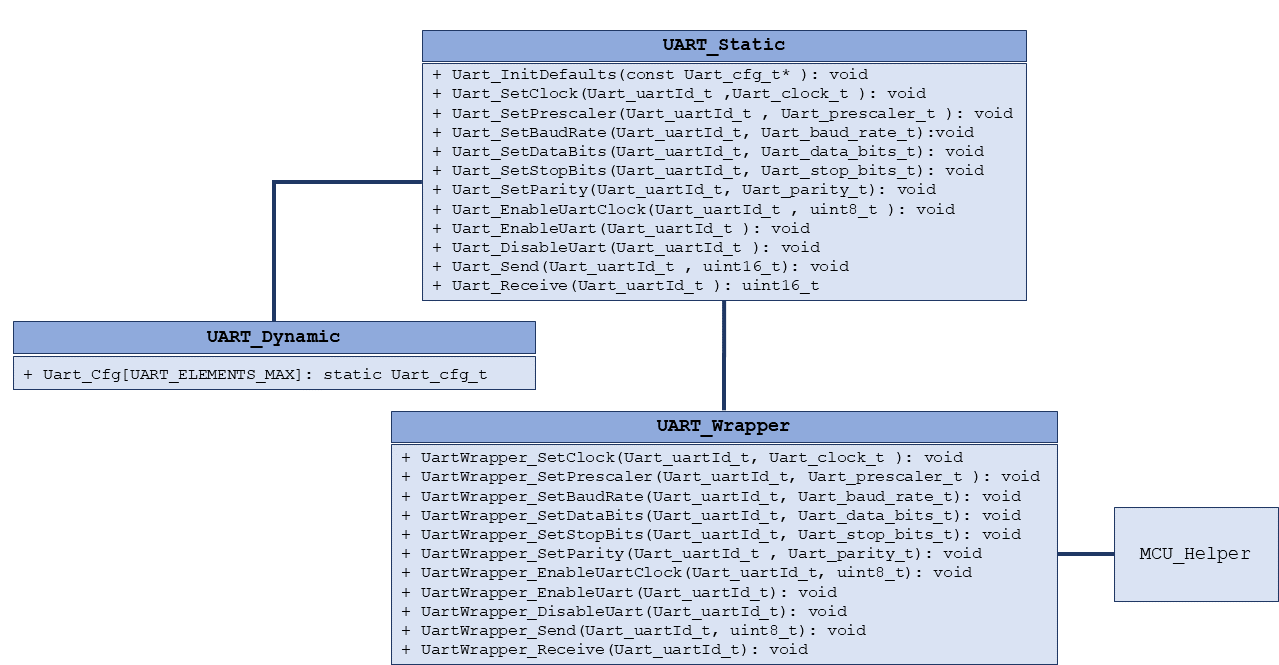
Figure 4. Analog-to-Digital Converter functions diagram.